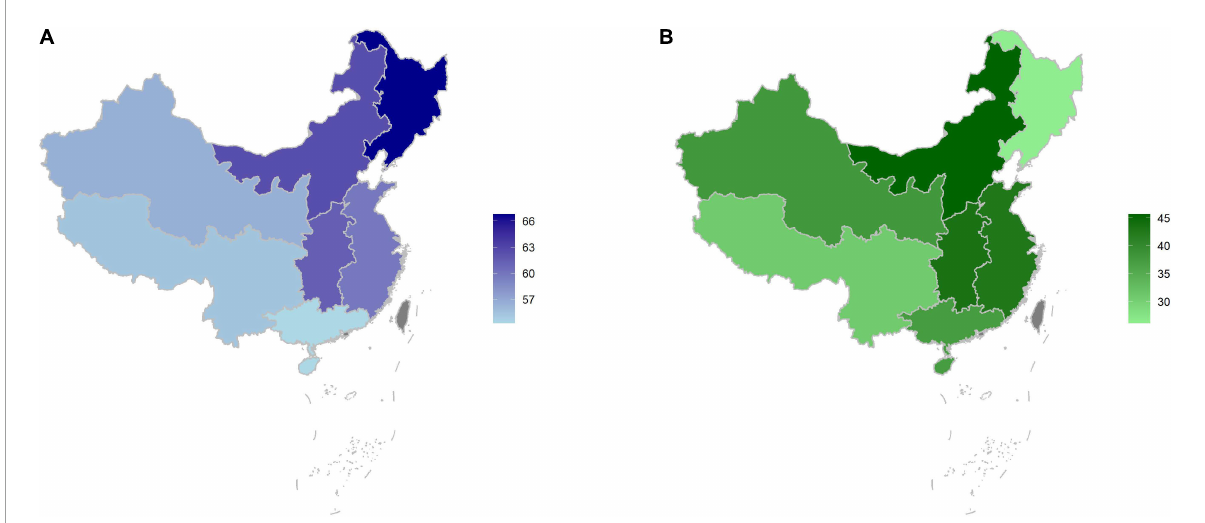
FIGURE2 Prevalence of elevated blood pressure (BP) among stroke survivors (A) and treatment rate among stroke survivors with elevated BP by geographic region (B) .